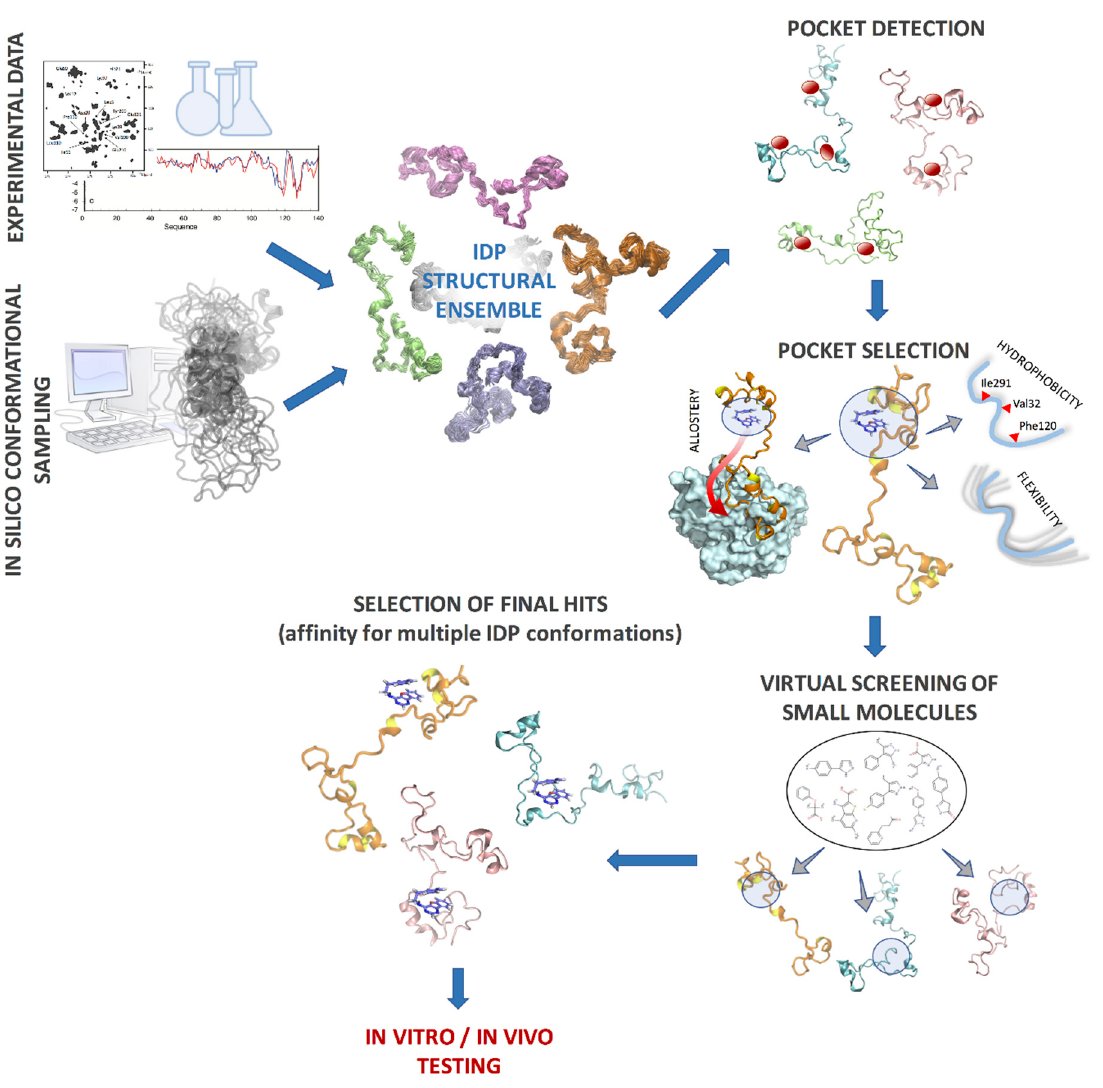
Figure 4. Example computational protocol for identifying drug candidates for IDPs; the IDP structural ensemble is clustered into representative conformations and druggable pockets are identified in each conformation; these pockets are further filtered by criteria such as hydrophobicity, backbone flexibility, and allosteric communication with functional sites. Virtual screening is performed in each pocket and final hits are selected based on high affinity in multiple IDP conformations.